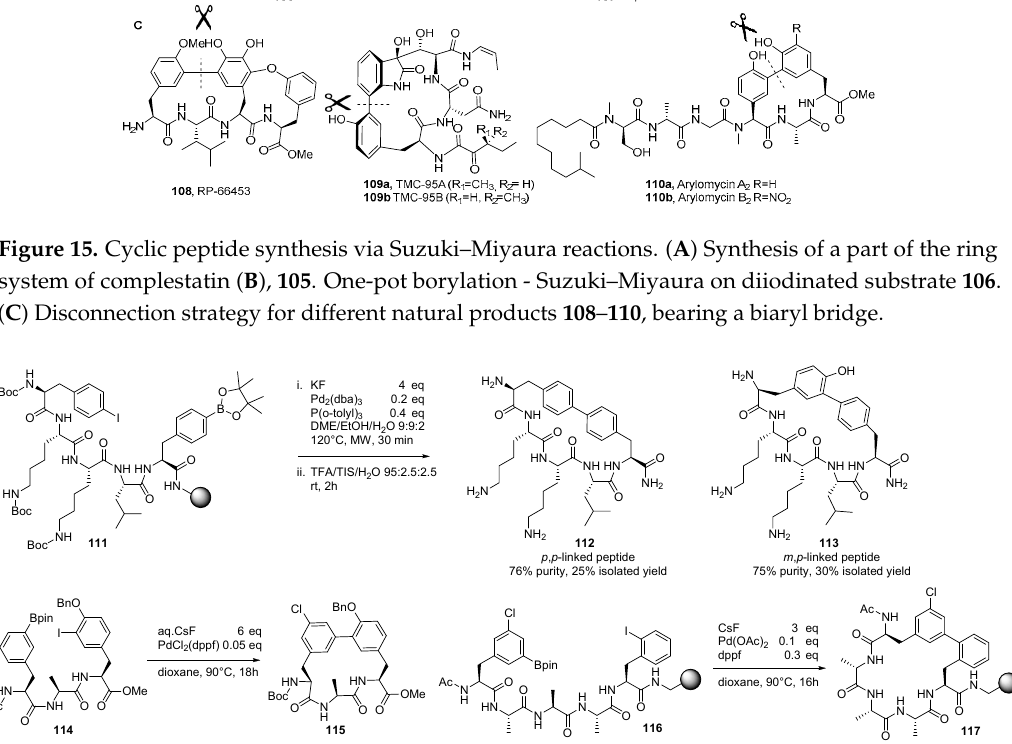
Figure 15. ( A ) Solid-phase synthesis of biaryl-linked peptide 112 with p , p -motif and 113 with m , p -motif. ( B ) Synthesis of m , m - and m , o -cyclic peptide 115 and 117 via respective solution-phase and solid-phase Suzuki–Miyaura.